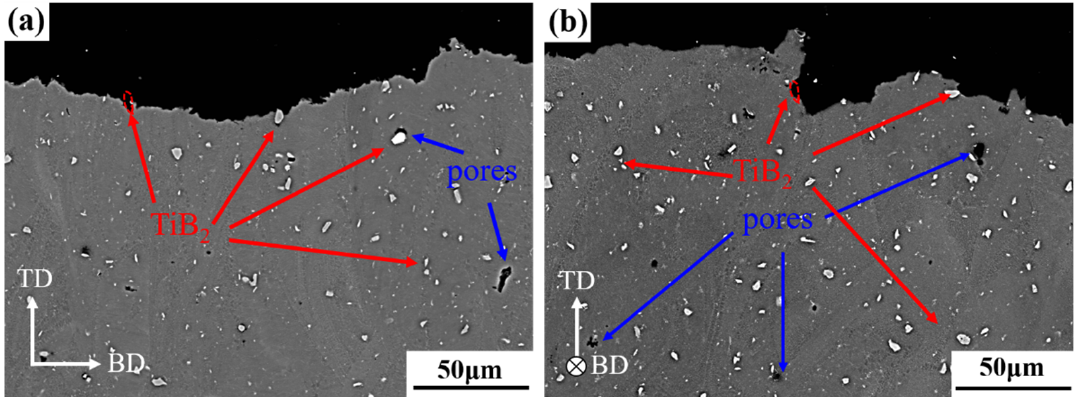
Figure 14. Fracture side surfaces of SLM-fabricated TiB 2 /AlZnMgCu(Sc, Zr) composite as-printed sample in relatively low magnification: ( a ) vertical plane and ( b ) horizontal plane.